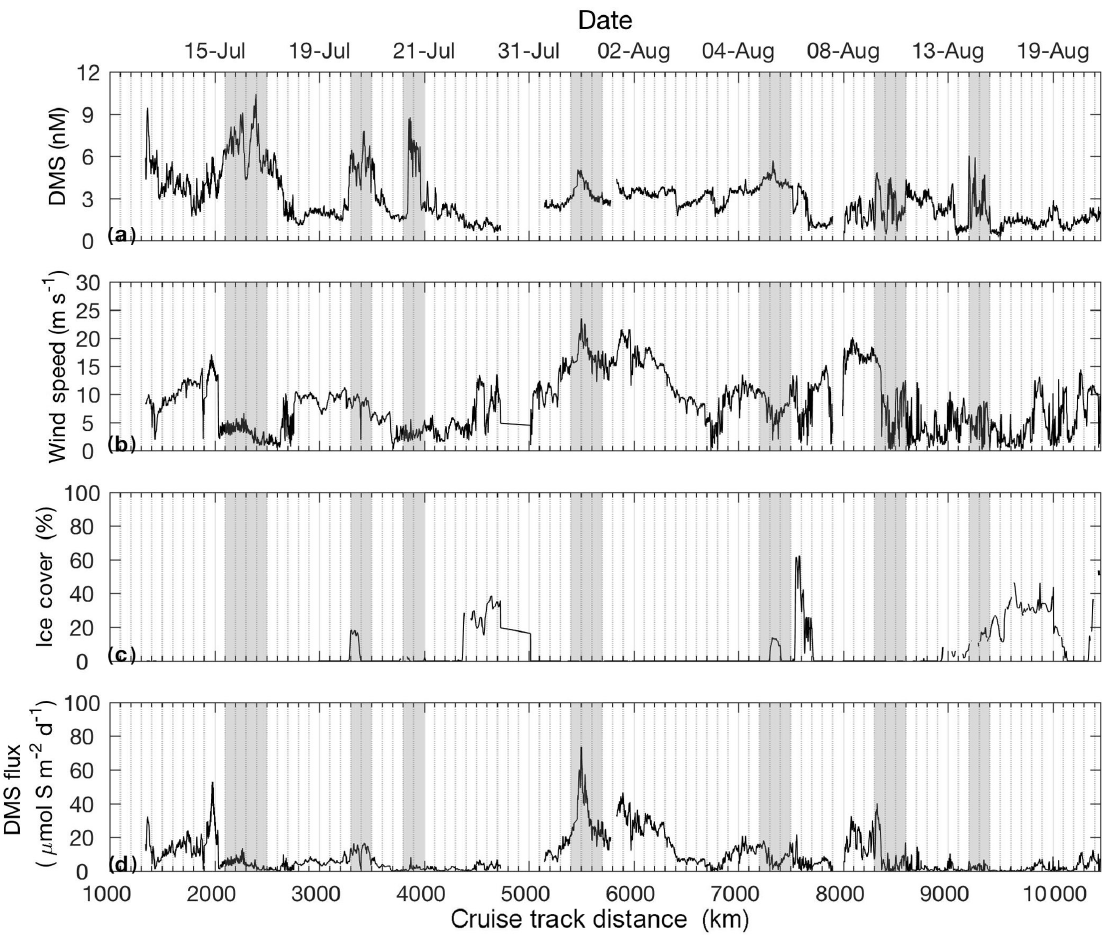
Figure 4. Distribution of DMS, wind speed, sea ice cover and sea–air DMS flux along the cruise